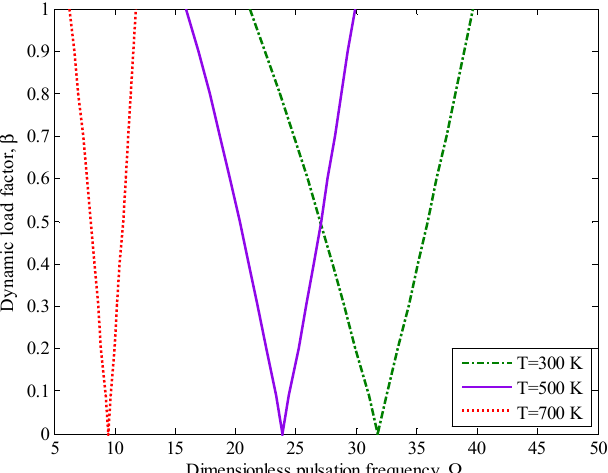
Figure 2. Temperature variation effect on the dynamic instability region (DIR) of the graphene sheet without elastomeric foundation.